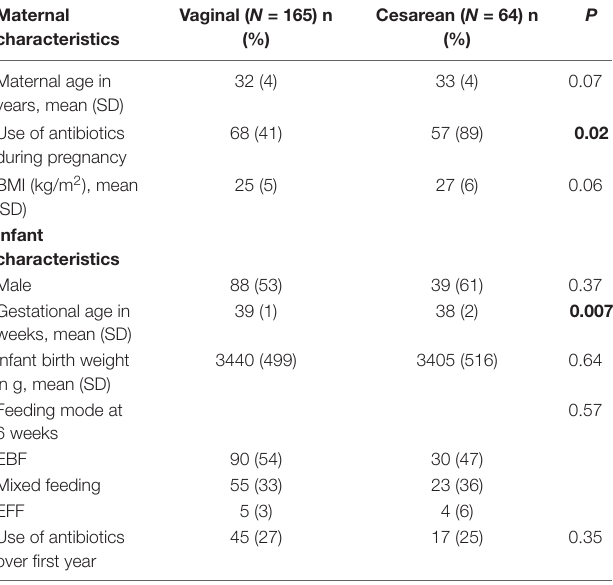
TABLE 1 | Characteristics of the Mother-Infant Dyads by Delivery Mode ( N =